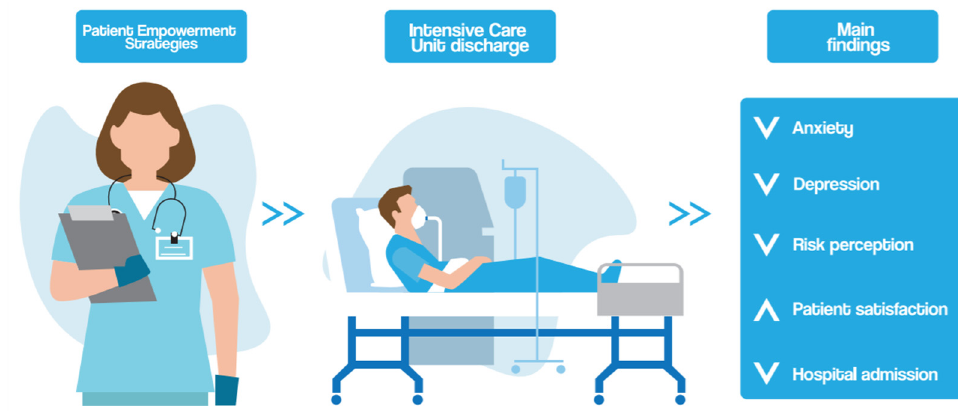
Figure 4. Main findings of patient empowerment strategies performed by nurses.